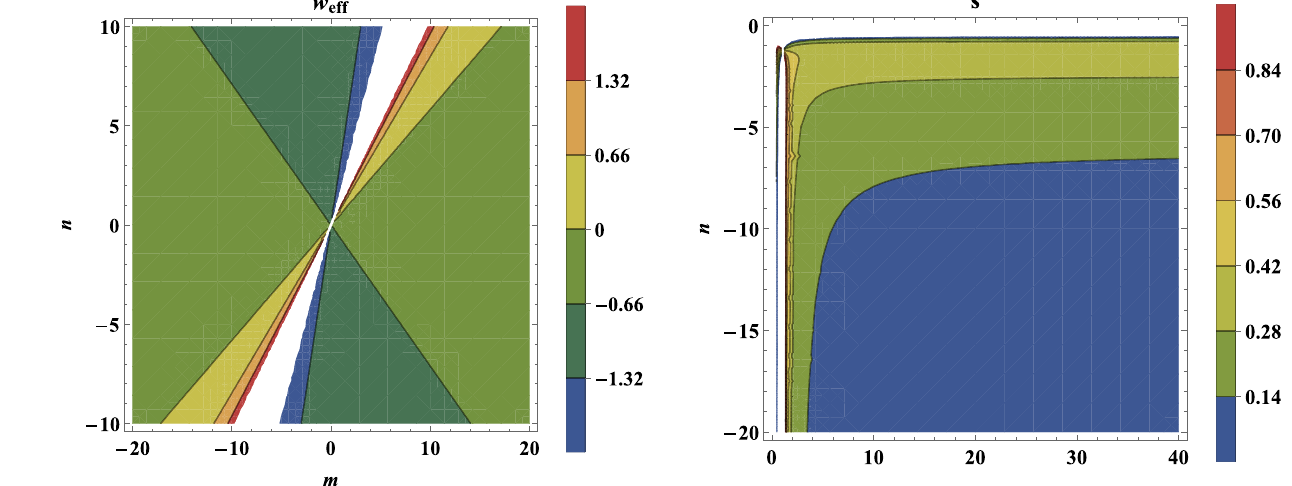
Fig. 5 The value of the s variable associated to the B critical point